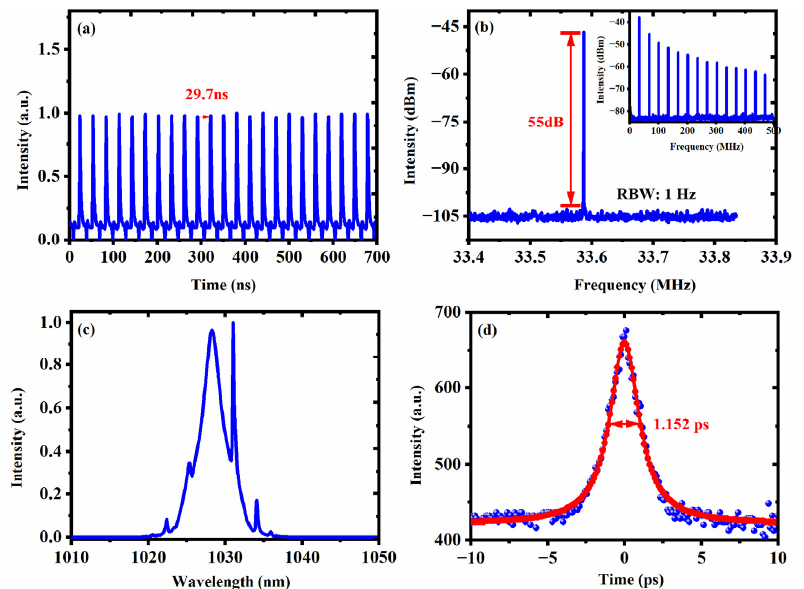
Figure 3. Mode-locked pulse measurements. ( a ) Optical pulse train. ( b ) RF spectrum. ( c ) Optical spectrum. ( d ) Autocorrelation trace.